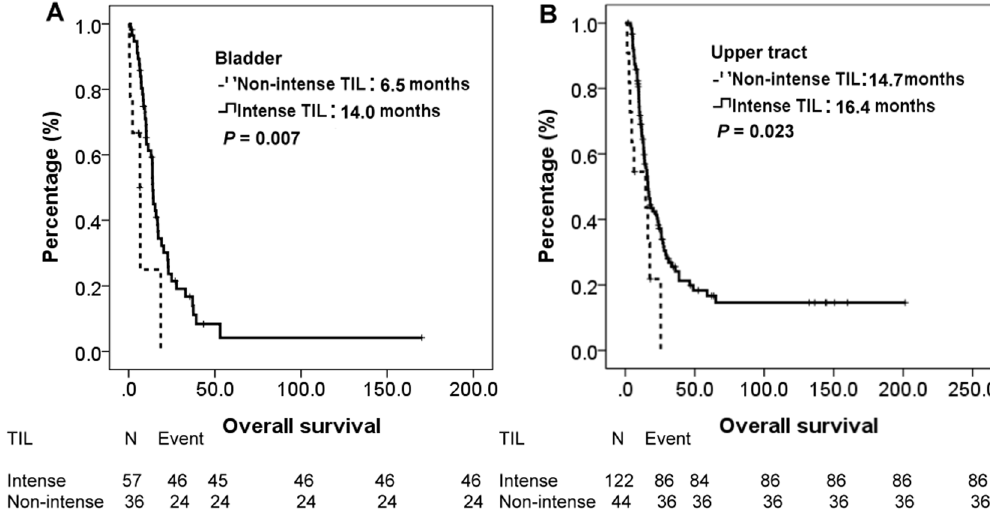
Figure 3. Representative urothelial carcinoma specimens stained with haematoxylin and eosin (H&E 100X) demonstrating examples with ( A ) intense intratumoral tumor infiltrating lymphocytes (itTILs) (black arrows), ( B ) intense stromal tumor infiltrating lymphocytes (sTILs) (black